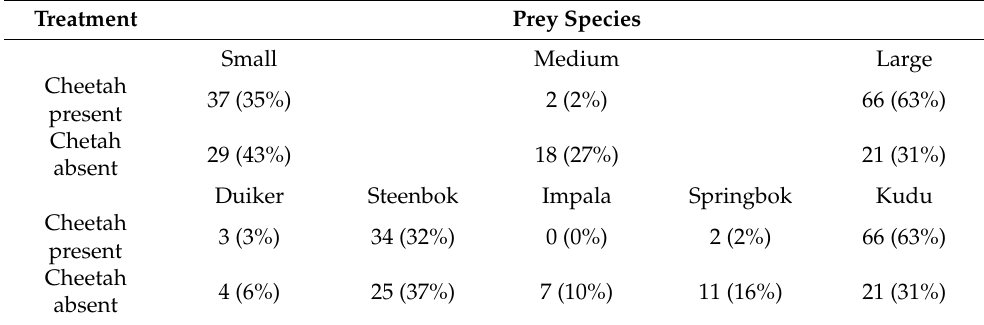
Table 1. Independent number of visits (according to body size and species-specific) by ungulates at waterholes during the cheetah-presence and cheetah-absence treatments. In brackets, percentages of sampling sessions that had visits by the specific species, in relation to the total number of sampling sessions for the respective treatment. Small—duiker and steenbok. Medium—impala and springbok. Large—greater kudu.